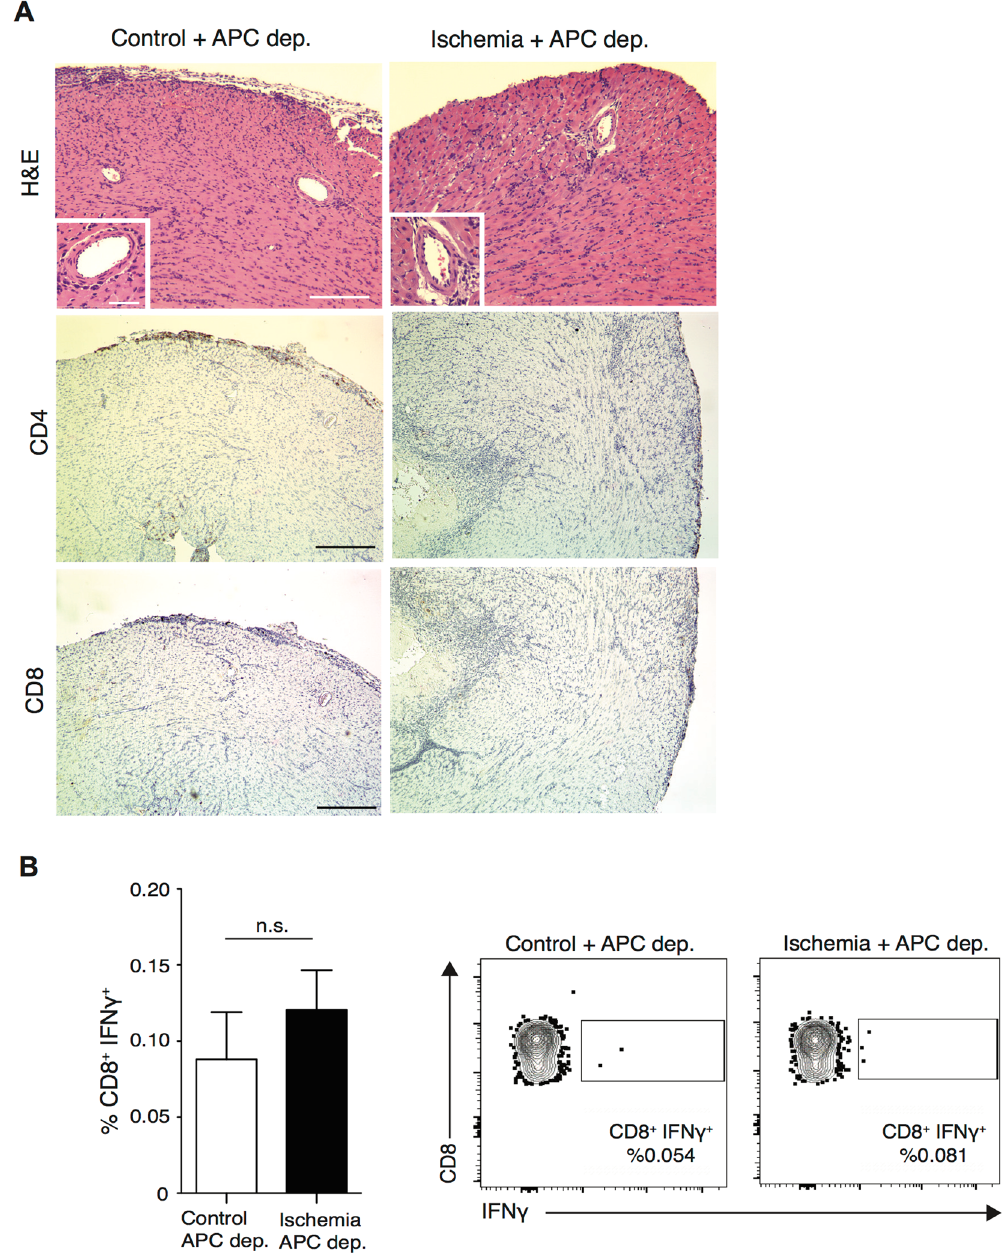
Figure 4. Intra-graft APCs play major role in recruiting alloreactive T cells to ischemic heart allografts. OVA heart donors were depleted of APCs by I.P. administration of liposomal clodronate on day − 8, − 5 and − 1 prior to transplantation. Control and ischemic hearts from clodronate treated-OVA donors were transplanted in to OTII recipients and grafts were harvested at day 6 post-transplant. ( A ) Histology of APC-depleted heart grafts showed mild inflammatory cell infiltrates, clear patent vasculature, with similar pattern between control and ischemic grafts. Infiltration of CD4 + and CD8 + T cells were similar between control and ischemic grafts. (Scale bar 100 μ m for H&E, CD4 and CD8 stain. Inset scale bar 30 μ m). ( B ) APC depleted control and ischemic heart grafts showed minimal infiltration with IFN γ producing CD8 + T cells, similar in both groups (0.09 ± 0.03% vs. 0.12 ± 0.02%, p = 0.46, n = 3/group); Representative flow plots, gated on CD8 + T